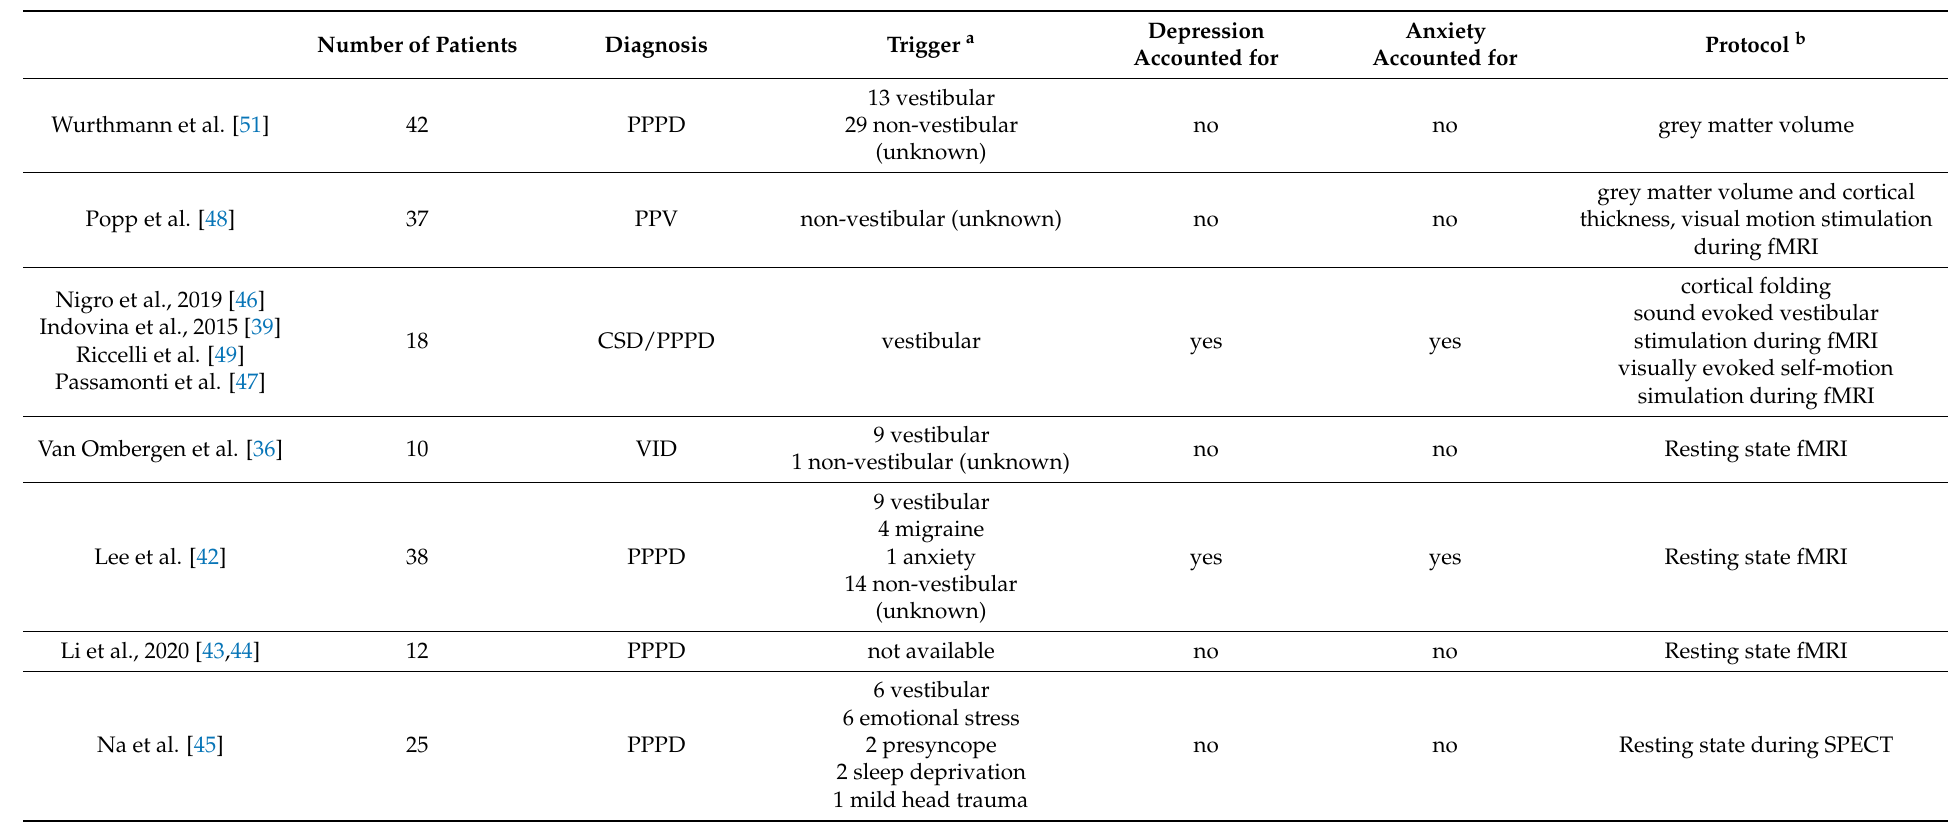
Table 1. Neuroimaging studies in patients with PPPD or related